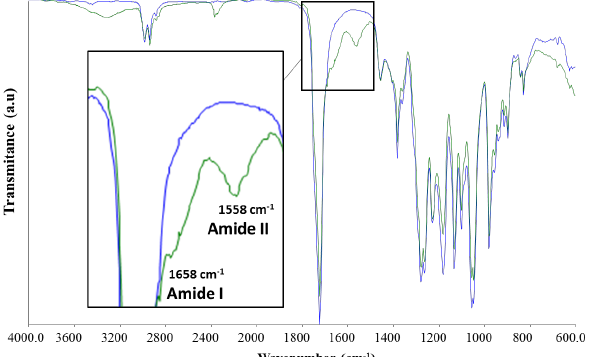
Figure 5. DSC thermograms of PHBV and PHBV-Collagen. Main peaks and respective enthalpies are Figure 3. ATR-FTIR analysis of unconjugated (blue) and conjugated (green) fibrous sca ff olds. summarized in the table below.